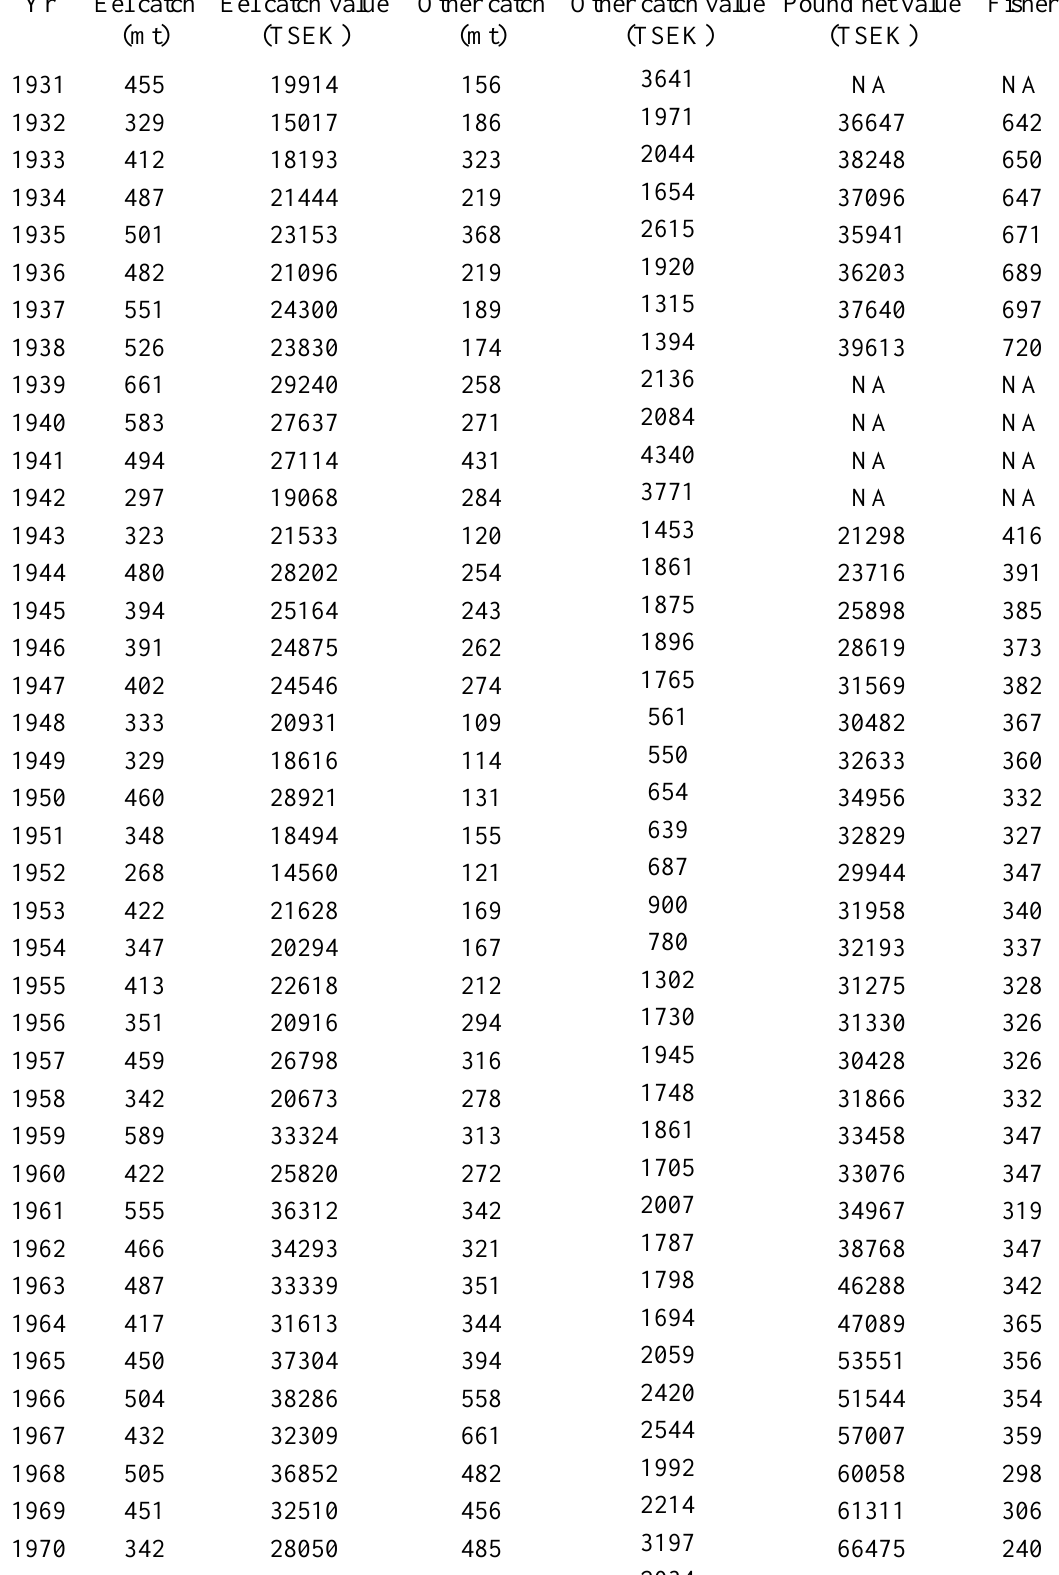
Table A1.2. Raw data of the pound net fishery in Kalmar County. Catch is presented in metric ton and catch value is presented in thousand Swedish krona